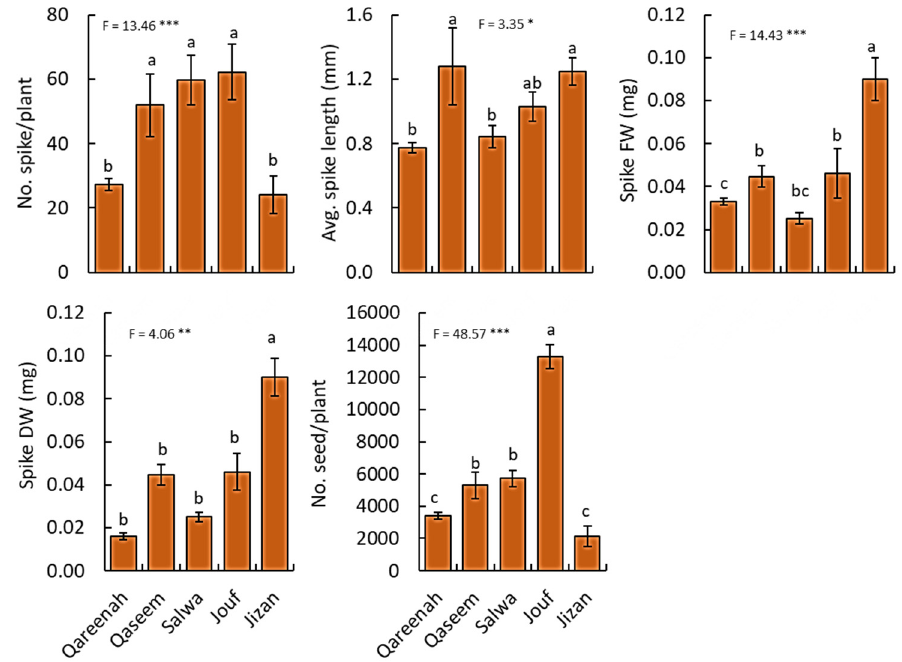
Figure 5. Reproductive traits for Aeluropus lagopoides growing in different saline flat regions of Saudi Arabia. Values are average ( n = 75 ), and the bar represents the standard error. Different letters among regions showed significant differences at p < 0.05 after Duncan’s test. * p < 0.05, ** p < 0.01, *** p < 0.001. FW: fresh weight, DW: dry weight.